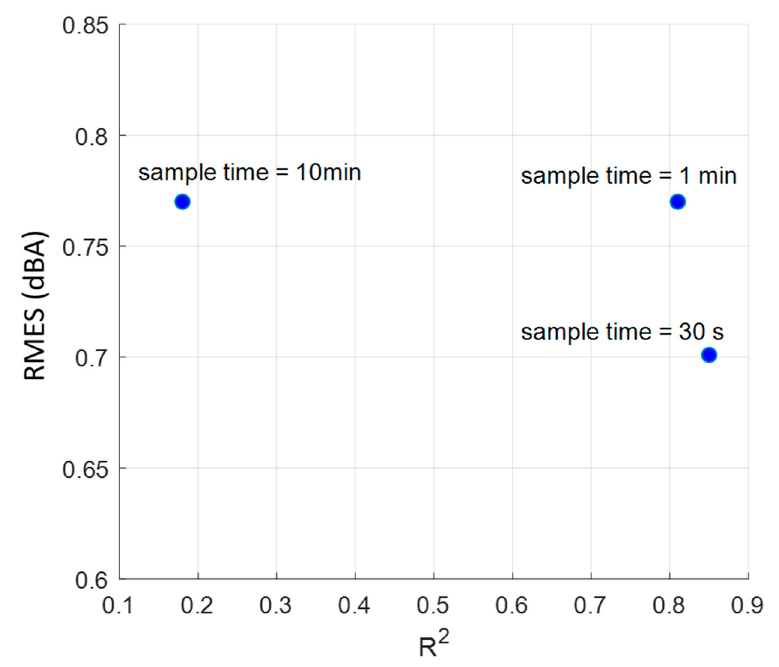
ff erent sampling times vs. predicted e ff Figure 12. Different sampling times vs. predicted effect. Figure 12. Di